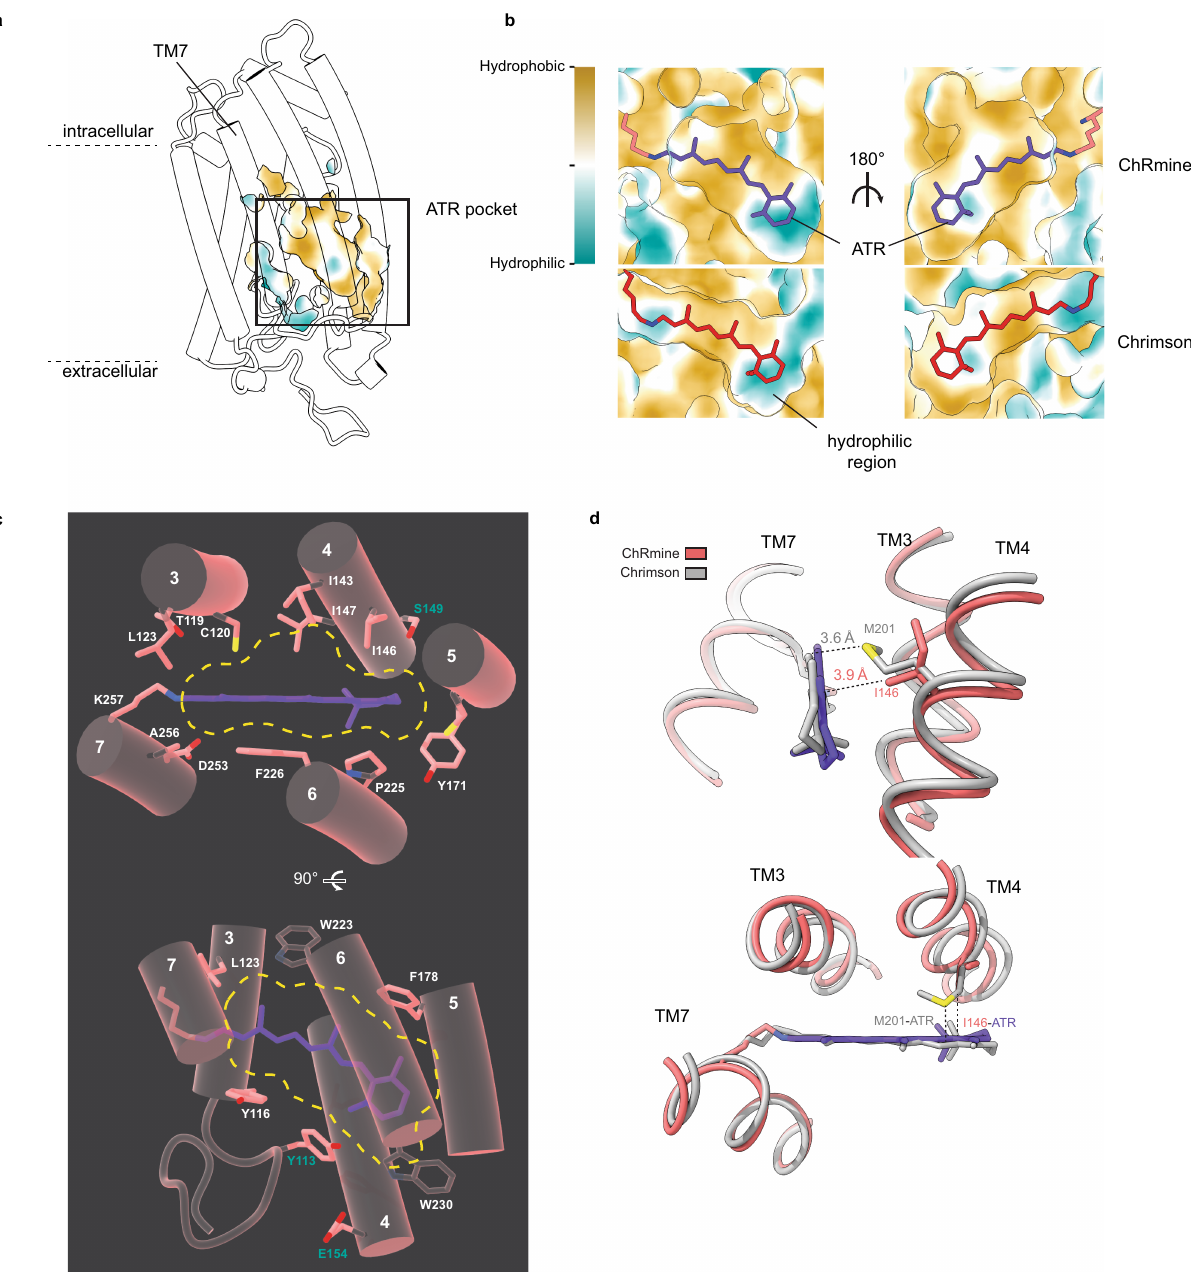
Fig. 5 | The ChRmine retinal binding pocket. a ChRmine viewed from the mem- brane plane with position of retinal binding pocket highlighted. b Views of the retinal binding pockets of (top) ChRmine and (bottom) Chrimson. Protein surface